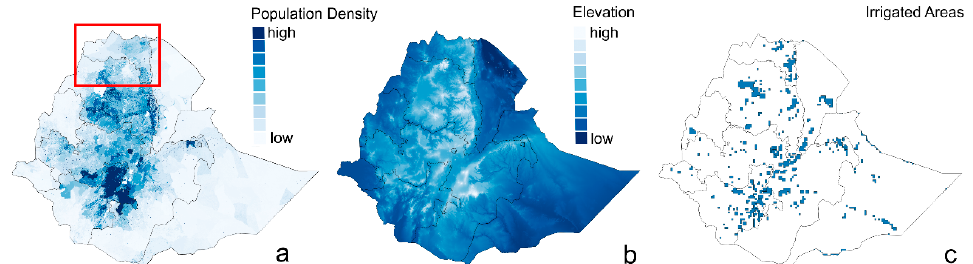
Figure 2. ( a ) Population density (Worldpop) in Ethiopia, increasing from light to dark blue, the red rectangle highlights the Tigray region in which farmers reported critical moisture deficits in 2007, 2013 and 2014; ( b ) elevation (CGIAR SRTM 90 m), increasing from dark blue (nearly sea level) to white (more than 4000 meters above sea level); ( c ) and irrigated areas (global map of irrigation areas, 2013).